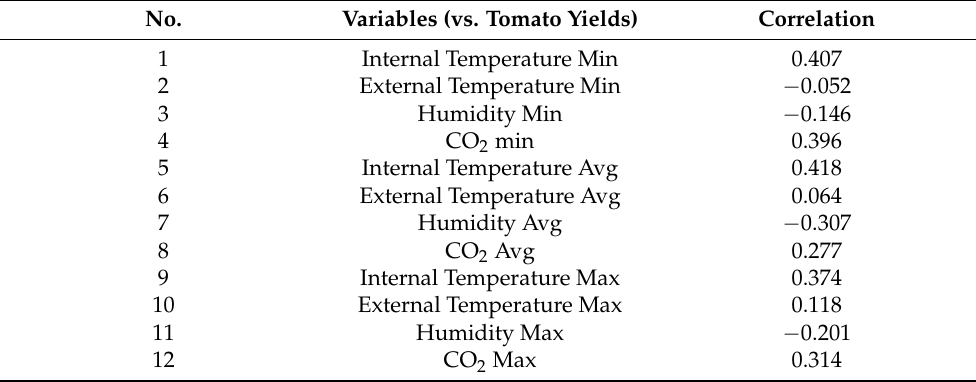
Table 3. Correlation coefficients between tomato yields and environmental factors.